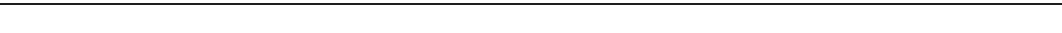
Fig. 3 Sirt2 regulates glucokinase and GKRP dissociation. a – c Immunoblot analysis (IB) with the indicated antibodies of total cell lysate and precipitates after immunoprecipitation (IP) with anti-DYKDDDDK (Flag) tag antibodies from Sirt2-knockdown primary hepatocytes transfected with adenovirus vector encoding Flag-tagged glucokinase (Flag-GK) cultured in low- or high-glucose medium ( a ), from db/db mouse-derived hepatocytes transfected with adenovirus vectors encoding Flag-GK and HA-tagged Sirt2 (HA-Sirt2) cultured in low- or high-glucose medium ( b ), and from db/db mouse-derived primary hepatocytes transfected with adenovirus vectors encoding Flag-GK with and without Sirt2 knockdown cultured in high-glucose medium with and without NMN ( c ). GKRP levels coimmunoprecipitated with Flag-GK were normalized to Flag-GK expression and are shown in the right graph of each fi gure ( n = 3 each). d Effect of Sirt2 knockdown on immunoprecipitation and immunoblot analysis of GK − GKRP binding in the liver from mice transfected with adenovirus vectors encoding Flag-GK 30 min after administration of glucose (4 g/kg) after 16-h fasting. e The interaction between Sirt2 and GKRP or glucokinase in primary hepatocytes detected by a fl uorescent-based system for detecting protein − protein interactions using hAG-tagged Sirt2, hAG-tagged GKRP, hAG-tagged GK, Ash-Sirt2, Ash-GKRP, and Ash-GK. Scale bars indicate 20 μ m. f Immunoprecipitation and immunoblot analysis of the interaction between Sirt2 and GKRP or Sirt2 and GK in HEK293 cells expressing Flag-tagged Sirt2, Halo-tagged GKRP, or Halo-tagged GK. g Immunoprecipitation and immunoblot analysis of GK − GKRP or Sirt2 − GKRP binding in mouse primary hepatocytes transfected with adenovirus encoding Flag-GKRP and HA-GK or HA-Sirt2 in low- or high-glucose medium. Data are normalized to control ( a − c ). * P < 0.05; one-way ANOVA with the Fisher ’ s PLSD post-hoc test ( a – c ). All data are representative of at least three independent experiments. Error bars show